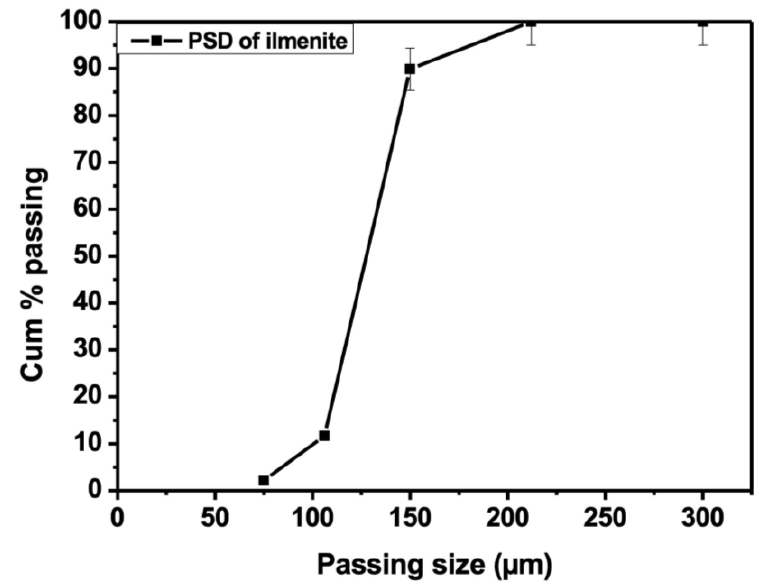
Figure 1. Particle size distribution of the as-received ilmenite ore.